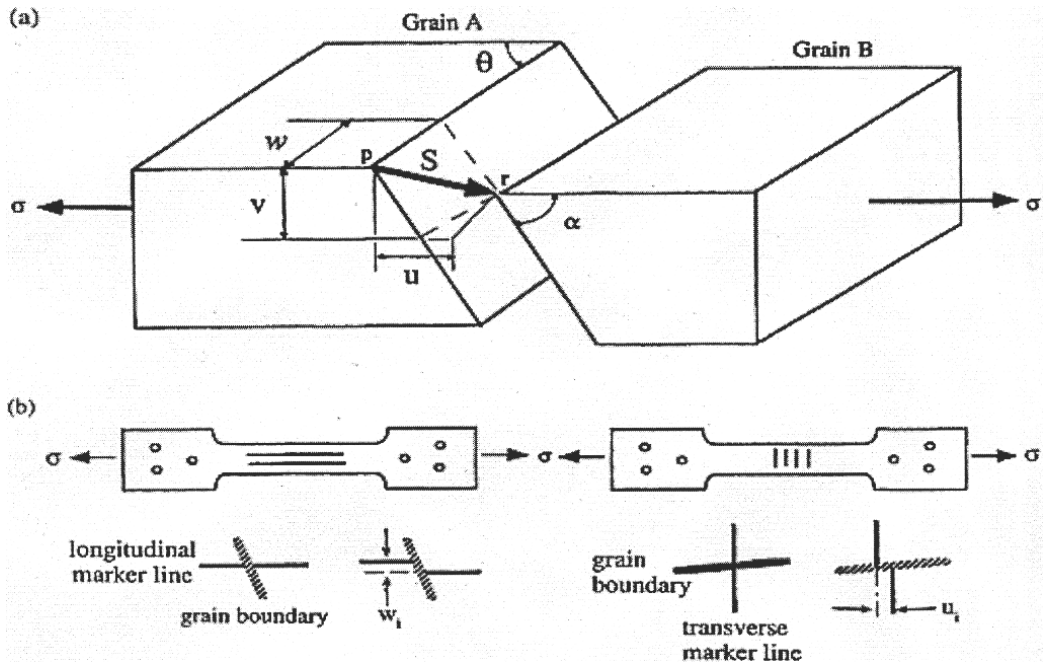
Figure 7. ( a ) Schematic representation of grain boundary sliding; ( b ) Schematic configuration of marker lines, longitudinal and transverse and their